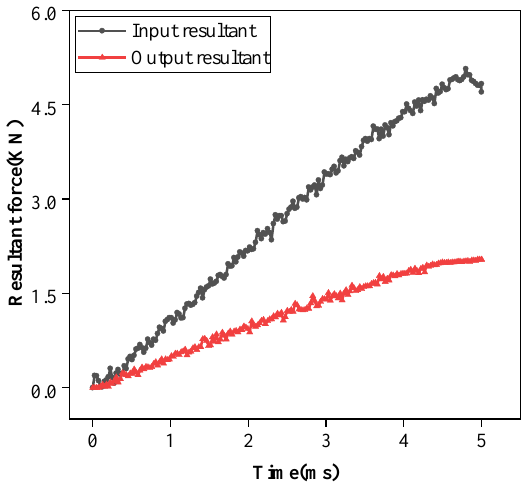
Figure 8. The resultant force of steel input and output varies with time.